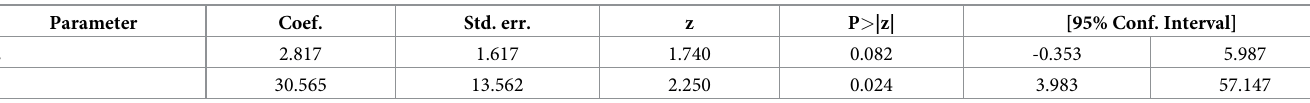
Table 5. The parameters of the Weibull-frailty function for the excavator’s failure data. Parameter Coef. Std. err. P > |z| [95% Conf.